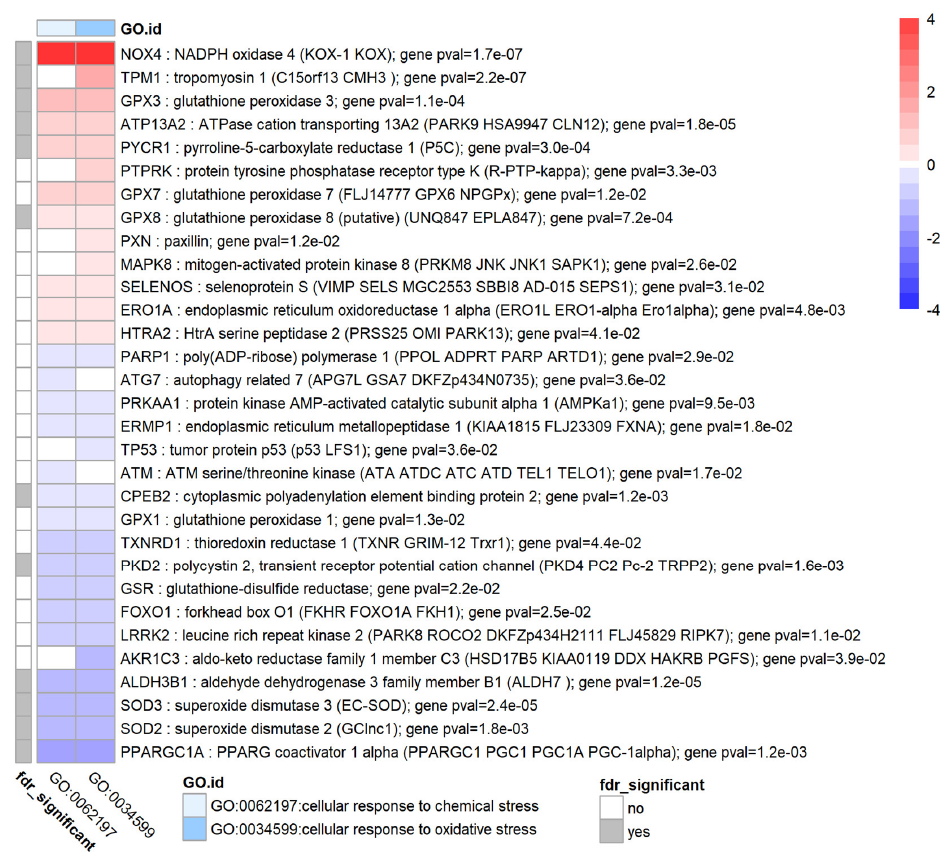
Figure 6. Genes and enrichment terms associated with extracellular signal molecules. Heatmap showing the genes with false discovery rate FDR < 0.05 for genes associated with growth factor activity and hippo signalling pathway. Heatmap colours correspond to fold change expressed as log 2 FC which has been limited to a range of [-4, 4] for clarity. The grey annotation bar on the left shows if the genome-wide false discovery rate is significant, FDR < 0.05 (in which FDR is the BH